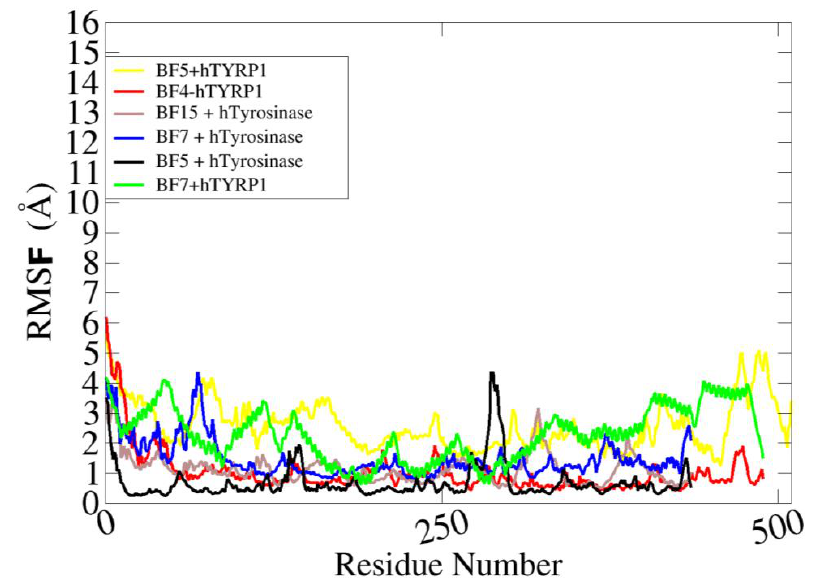
Figure 10. Residue level fluctuation of complexes.